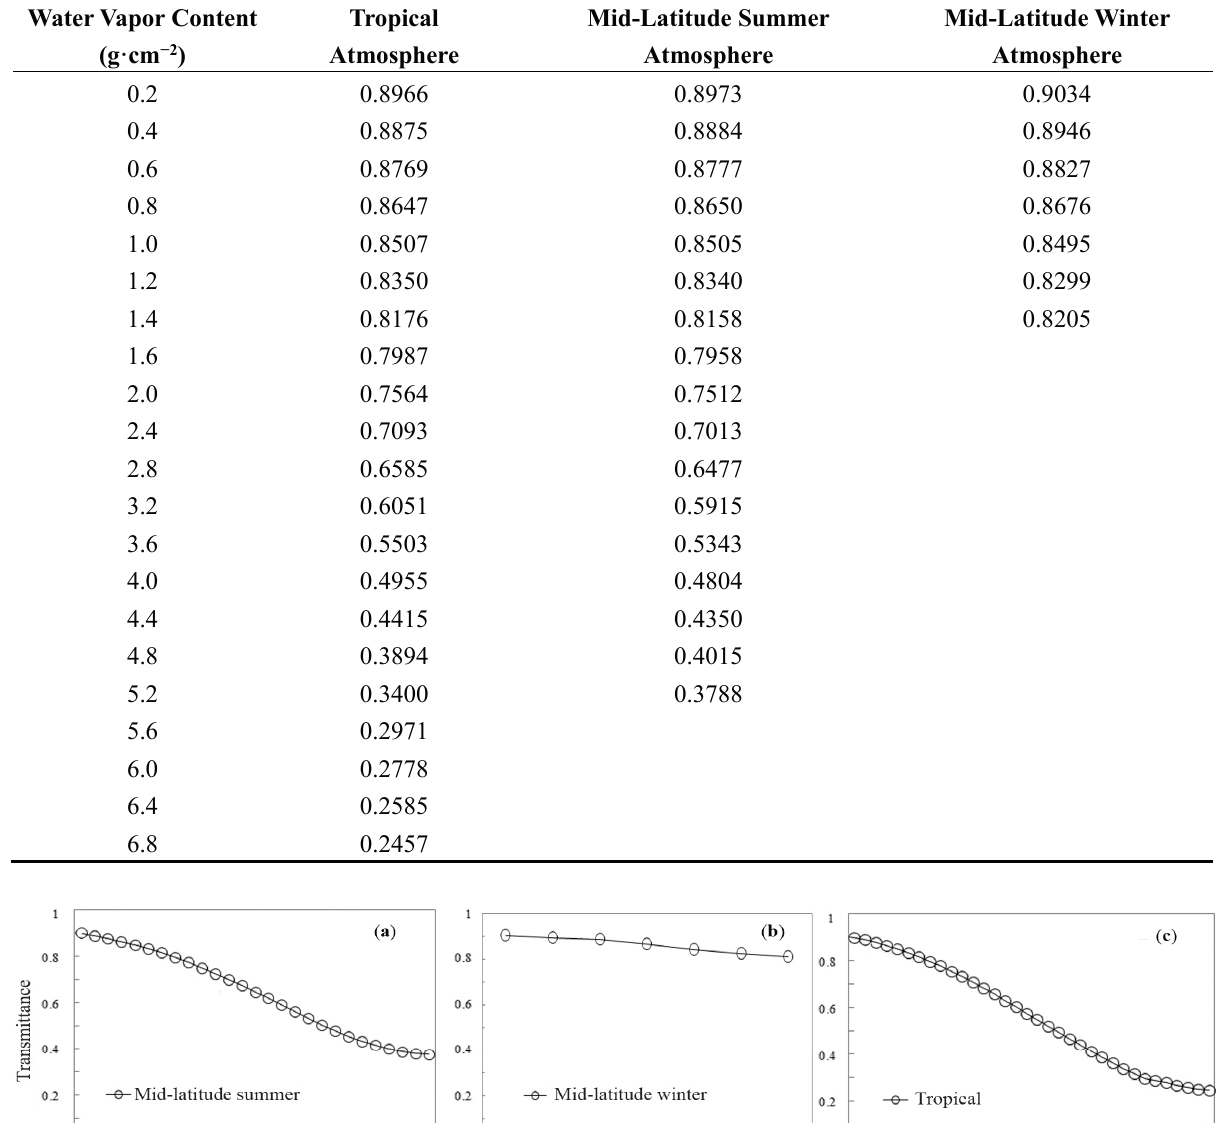
Table 5. Change of atmospheric transmittance with water vapor content for Band 10 under various standard atmospheres.